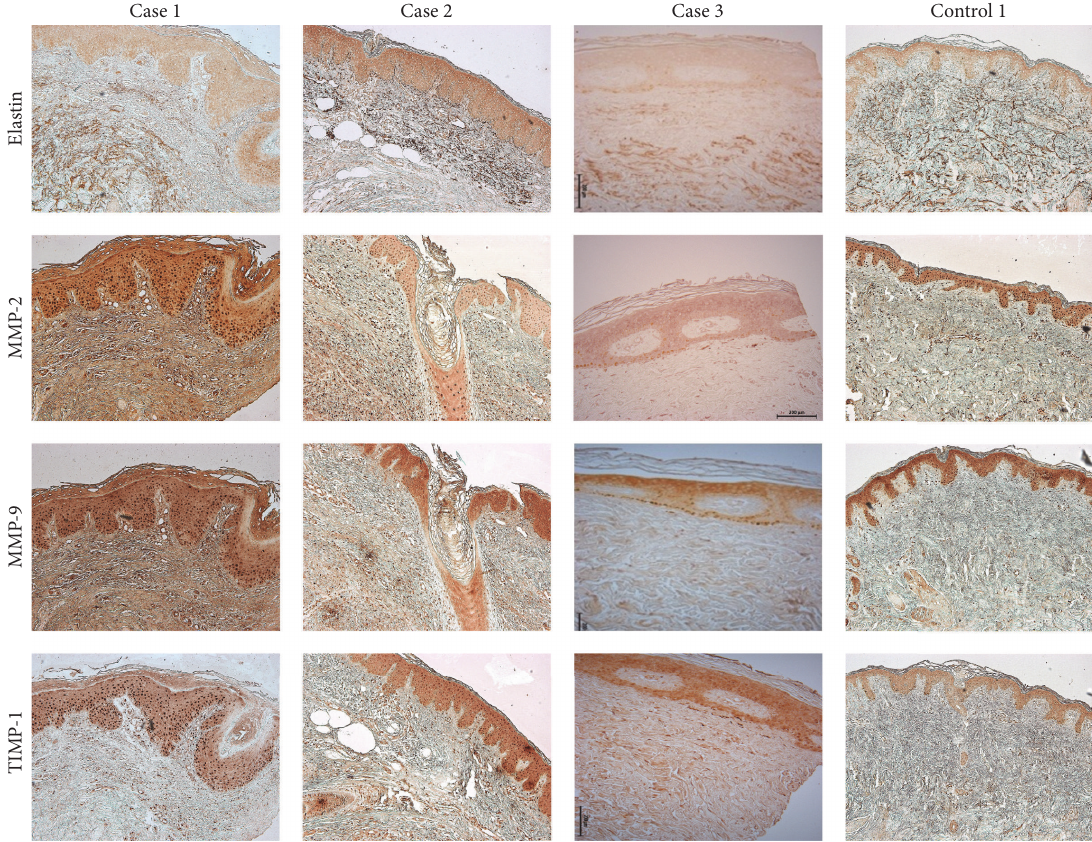
Figure 4: Immunohistochemical study results for elastogenesis and degradation markers in protruding and indented type anetoderma (cases 1 and 2: protruding anetoderma lesions, case 3: indented anetoderma lesion, and control 1: control of case 1) (magnification: ×